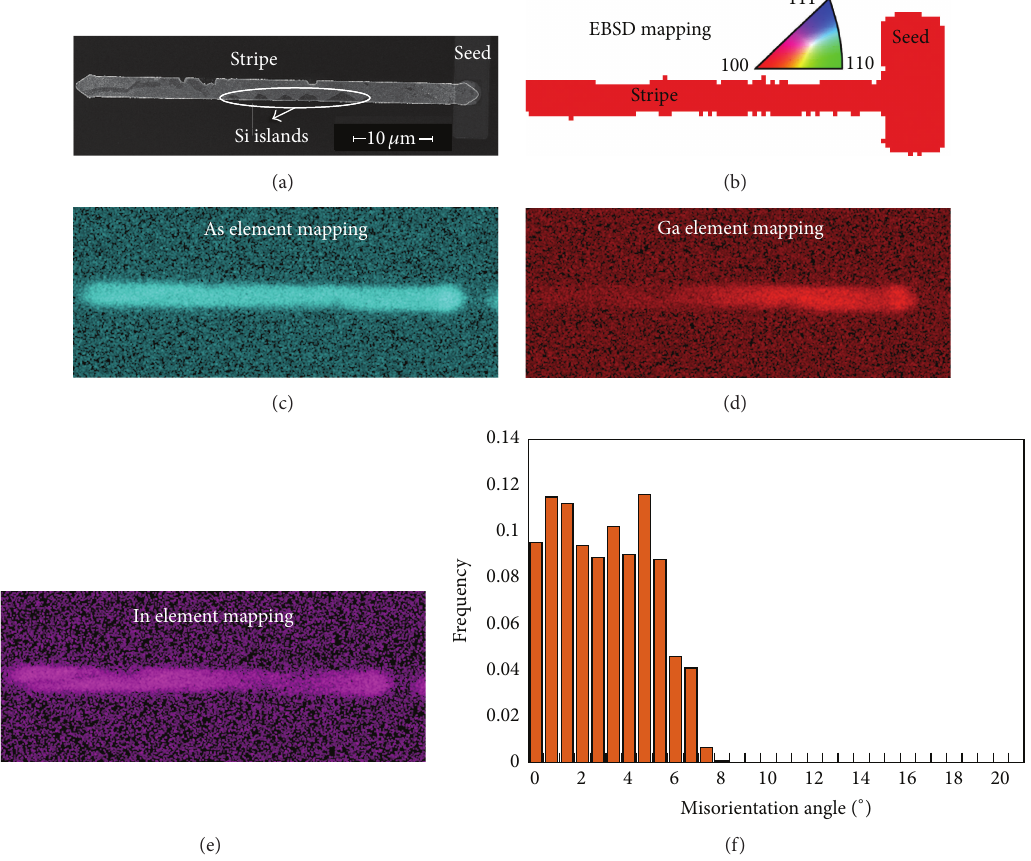
Figure 1: (a) SEM image of RMG InGaAs. Dark regions in the white circle are Si islands. (b) EBSD image of the crystal orientation. (c) EDS map for As element of the same InGaAs stripe. (d) EDS map for Ga element of the same InGaAs stripe. (e) EDS map for In element of the same InGaAs stripe. (f) Misorientation distribution of the InGaAs